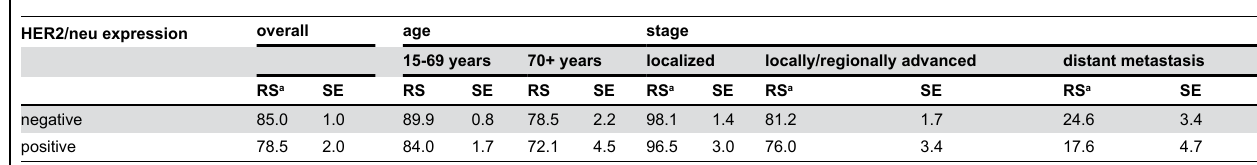
Table 6. Five-year relative survival of female patients from Saarland with invasive breast cancer (ICD-10 code: C50) by HER2/neu expression and stratified by age and stage estimated for the calendar period 2005-2009 based on completed